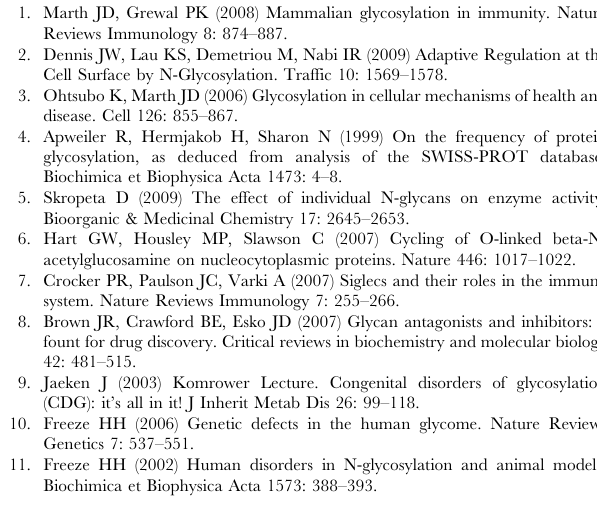
Figure S1 PANC1 cells were treated with RNAi against HNF1 a and HNF4 a . The expression levels of the indicated genes were analysed by real time SYBR Green PCR. Figure S2 PANC1 cells were treated with RNAi against HNF1 a and HNF4 a . The expression levels of the indicated genes were analysed by real time SYBR Green PCR. Figure S3 The clustering of FUT3, FUT5 and FUT6 on chromosome 19. The position of primer pairs used for ChIP are indicated at the bottom of the figure. Table S1 (A) Main structures present in glycan groups for which Genome-wide significant associations were found (SNPs in FUT8 , FUT6 and HNF1 a genes). (B) Glycan structures present in different HPLC peaks.